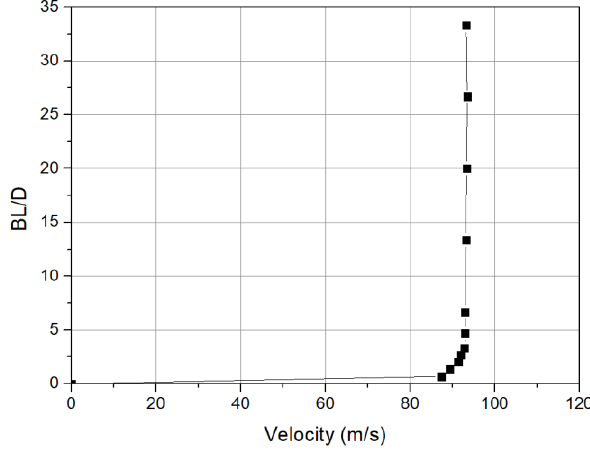
Figure 5. Velocity profile 20 mm upstream from the film-cooling hole.